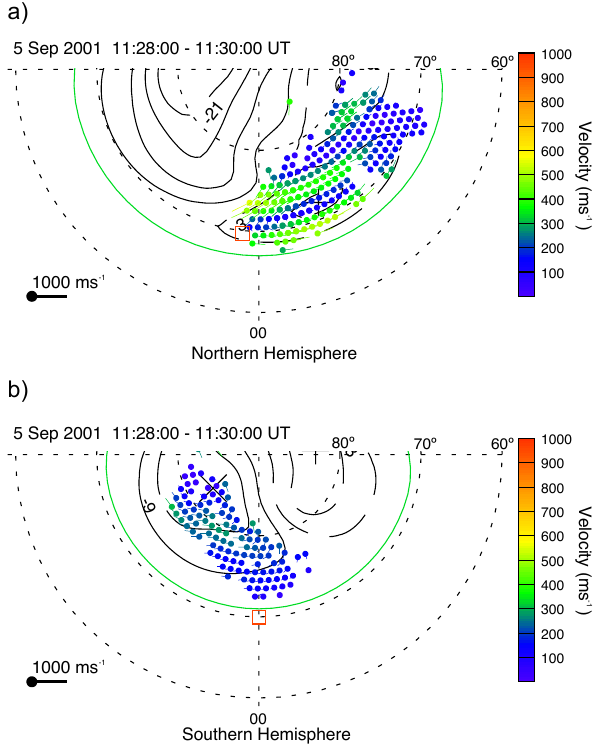
Figure 8. SuperDARN ionospheric plasma convection (a) in the Northern Hemisphere and (b) in the Southern Hemisphere in AACGM latitude – magnetic local time coordinate system on 5 September 2001 at 11:28–11:30UT. The contours of the iono- spheric electric potential are superposed by the black solid and dashed lines. The green line indicates the low-latitude boundary of the ionospheric convection. The T96 footprint of Cluster is marked by the red